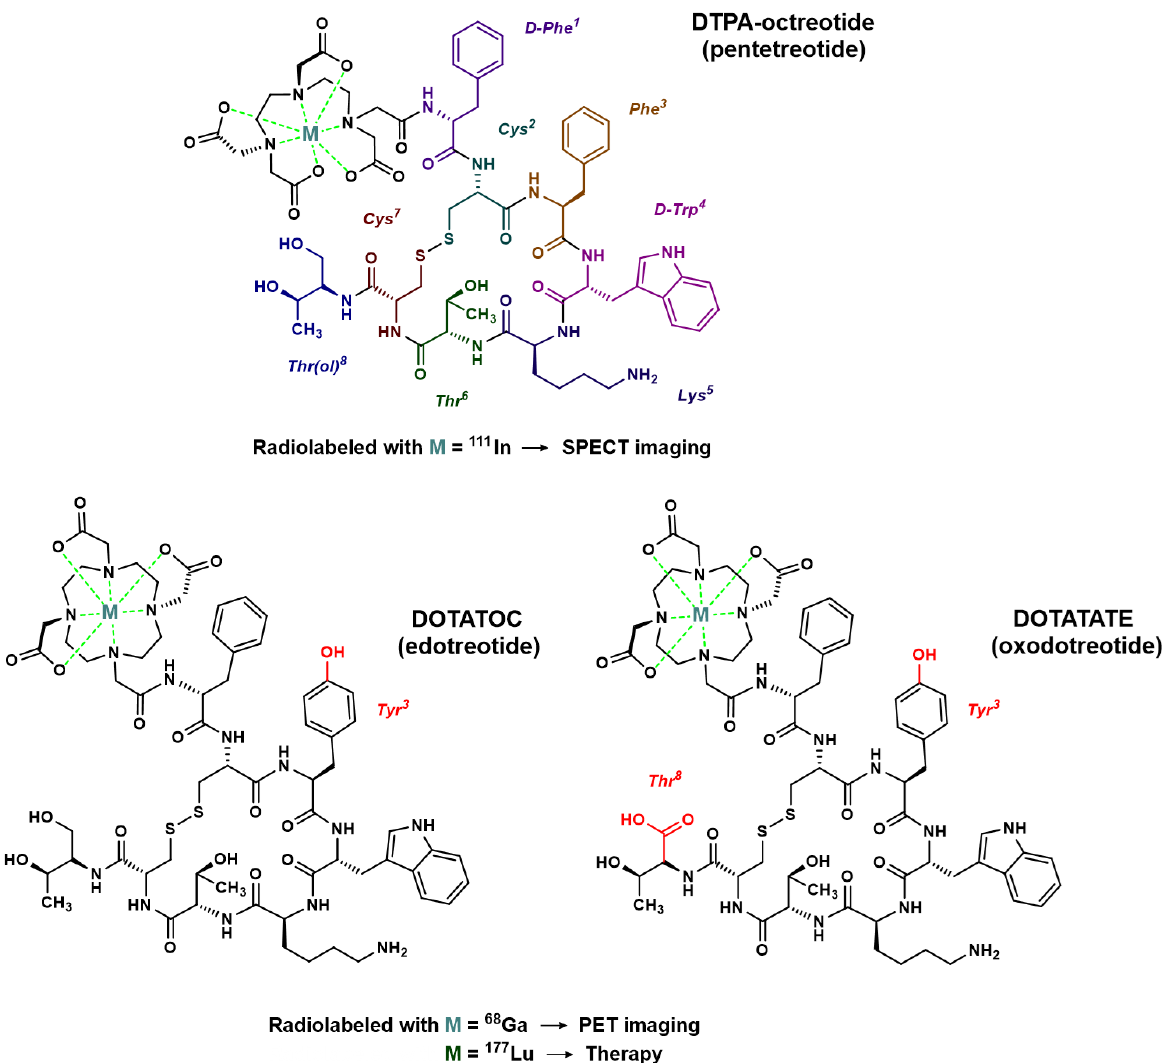
Figure 2. Chemical structure of octreotide analogs most commonly used for molecular imaging or treatment of NETs. In red: modifications of the peptide sequence in comparison to octreotide.